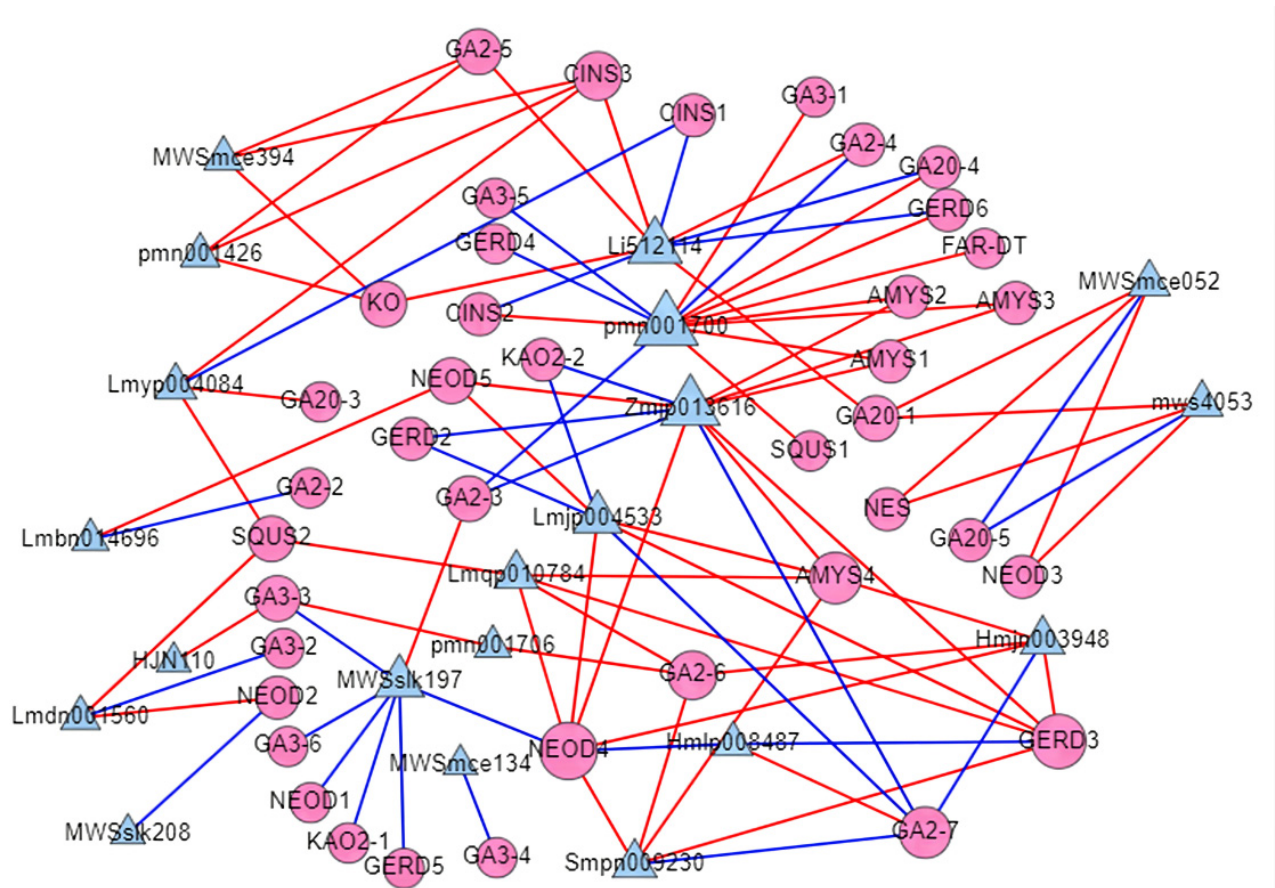
Figure 6. Correlation analysis of TPS genes and released amounts of terpene compounds (Pearson correlation coefficient > 0.8). The circular nodes are TPS genes, the triangular nodes are terpenes, the red line represents positive correlation, and the blue line represents negative correlation.